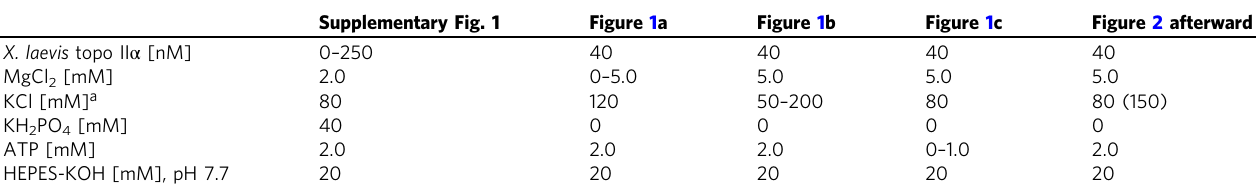
Table 1 Buffer compositions used for various chromatid reconstitution assays.